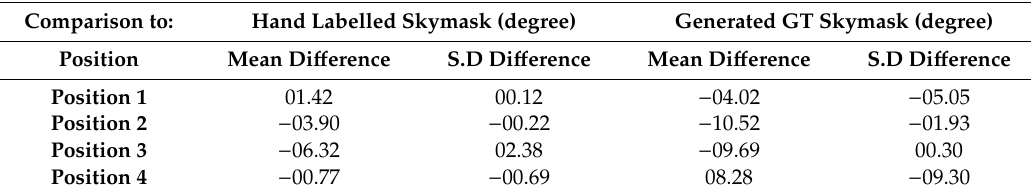
Table 3. Segmented skymask